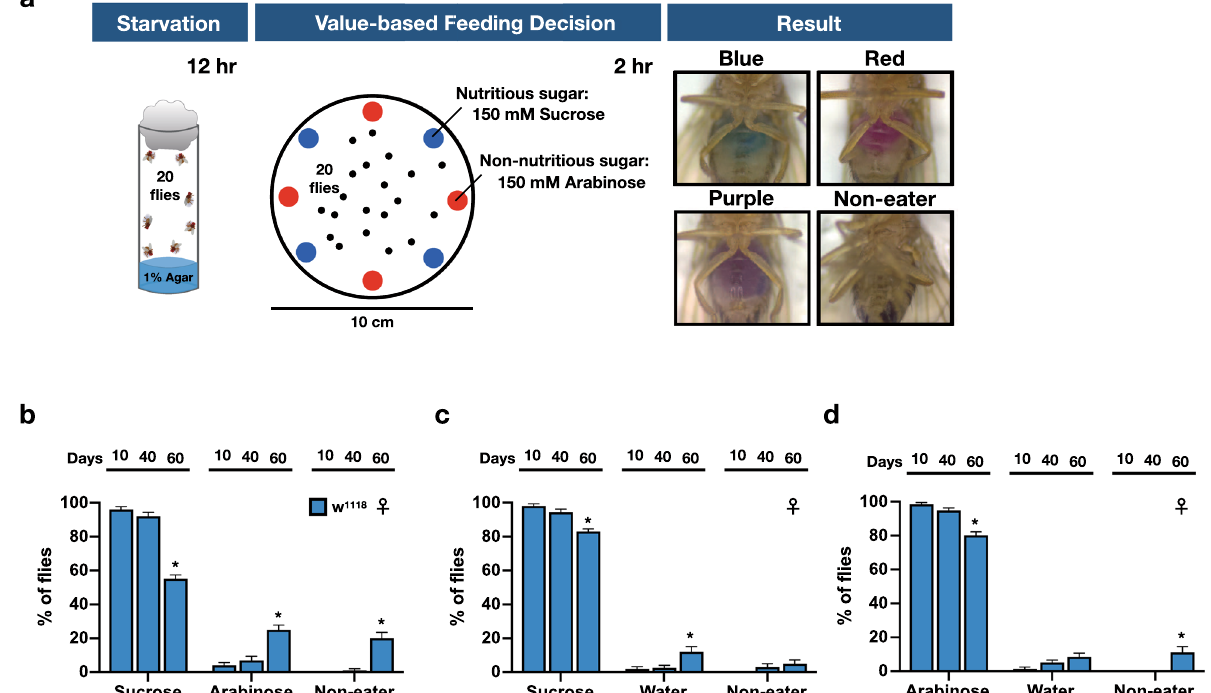
Fig. 1 The ef fi cacy of making proper VBFD is gradually deteriorating in aging fl ies. a A schematic illustration of VBFD assay. Brie fl y, food- deprived fl ies (12 h of starvation) were presented with two liquid food choices and allowed to feed for 2 h at 25 °C. Each liquid food is labeled by a red or a blue dye. The feeding decision was scored by examining the colors shown in the abdomen. Red or Blue color shown in the abdomen suggests fl ies only ingest only either one food choice. Purple indicates the fl ies consume both food choices during the feeding assay. Non-eater means the fl ies have no labeled food in the digestive tract. b – d VBFD assays were performed in female fl ies of different chronological ages: 10, 40, and 60 days. The food choices used were 150 mM sucrose and 150 mM arabinose in ( b ); 150 mM sucrose and plain water in ( c ); 150 mM arabinose and plain water in ( d ). Results were expressed as means ± SEM and analyzed by two-way ANOVA. n = 100 for each condition. * p < 0.01. The statistical signi fi cance was assessed by the comparison to 10-day-old fl ies. All fl ies used in above assays were maintained at 25